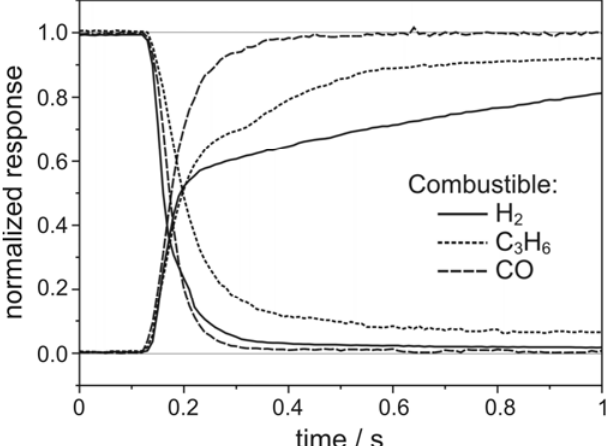
Figure 4. Normalized response of a miniaturized planar gas sensor at 650 °C. Cell symbol: Au,NiO/YSZ/Pt with Au,NiO composite mixed potential electrode (YSZ, yttria stabilized zirconia) Reprinted from [34] with permission from